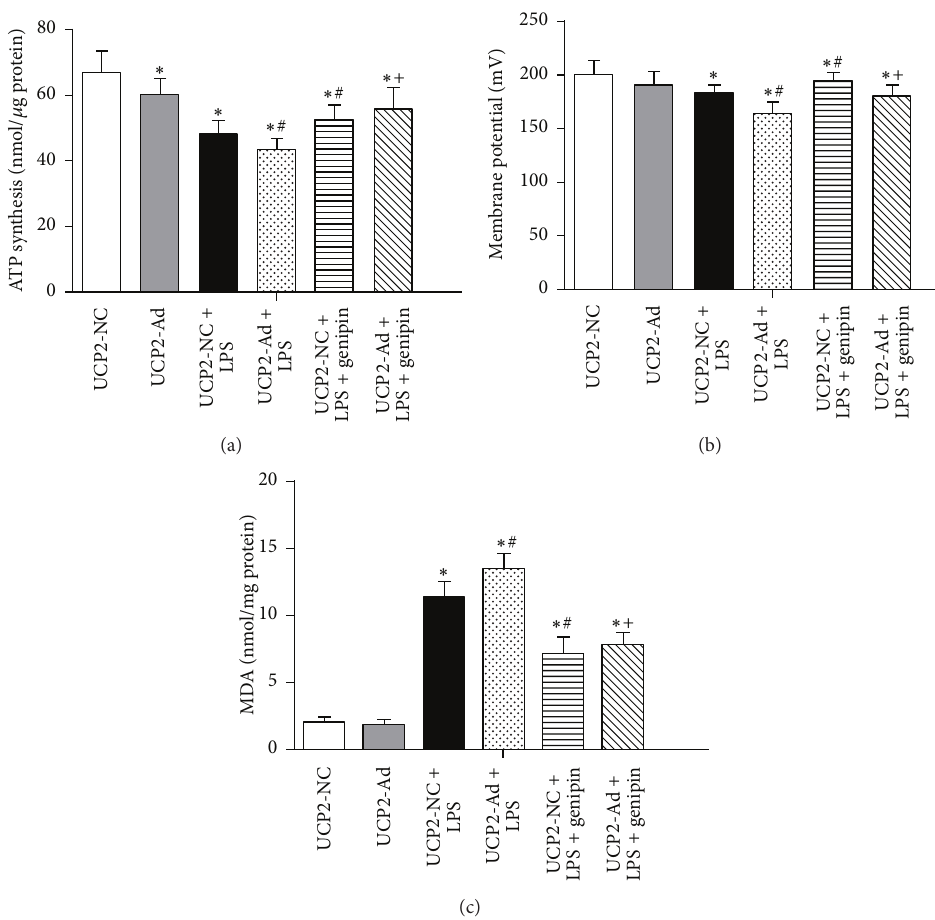
Figure 3: Effects of UCP2 on mitochondrial ATP levels, membrane potential, and ROS production in lung tissue. (a) ATP levels were measured by a luciferase-based assay in isolated mitochondria. (b) The membrane potential ( Δ𝜓 m) of isolated mitochondria (1mg/mL) was measured using Rhodamine 123 (1mM). (c) Lipid peroxidation (MDA assay) were measured in the lung tissues of mice ( ∗ 𝑃 < 0.05 versus UCP2-NC + saline group, # 𝑃 < 0.05 versus UCP2-NC + LPS group, and + 𝑃 < 0.05 versus UCP2-Ad + LPS group). Values are presented as means ± SEM ( 𝑛 = 8